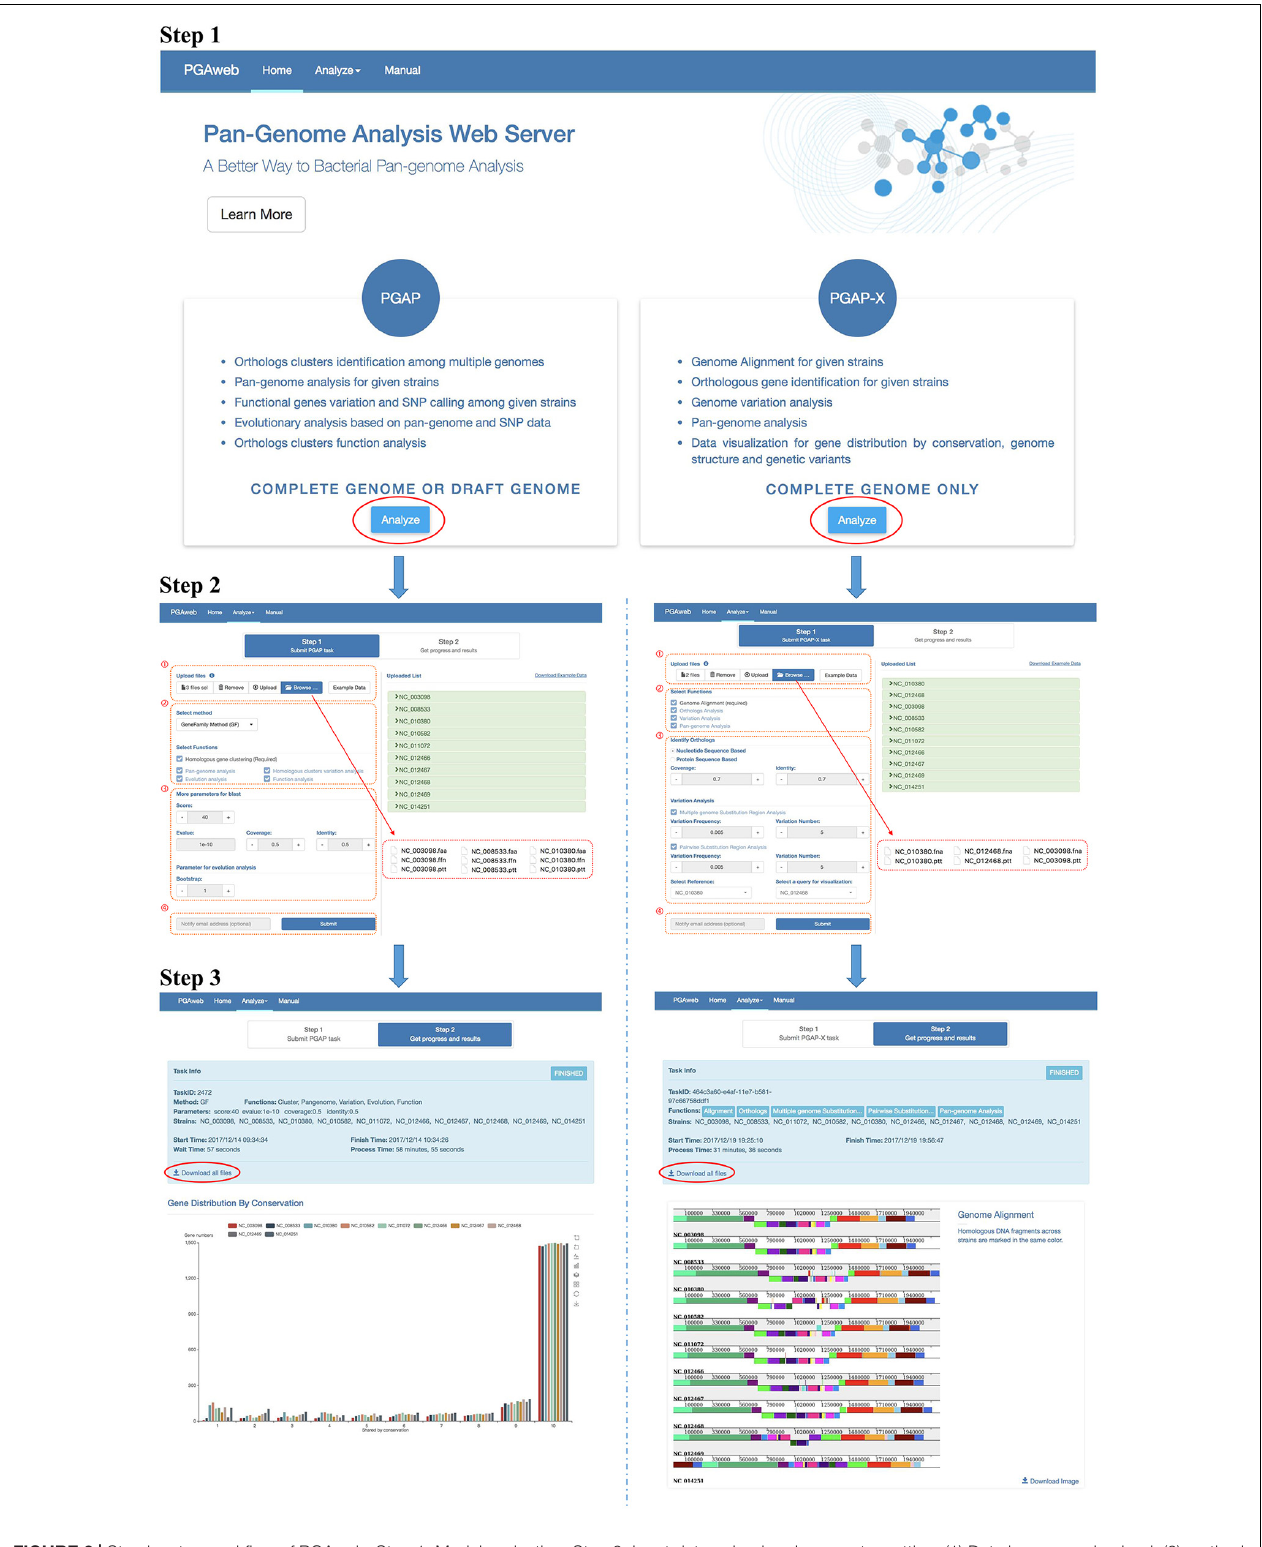
FIGURE 2 | Step by step workflow of PGAweb. Step 1: Module selection. Step 2: Input data upload and parameter setting. (1) Data browse and upload, (2) method and function selection, (3) parameter setting, and (4) fill in e-mail address and submit job. Step 3: Results download.